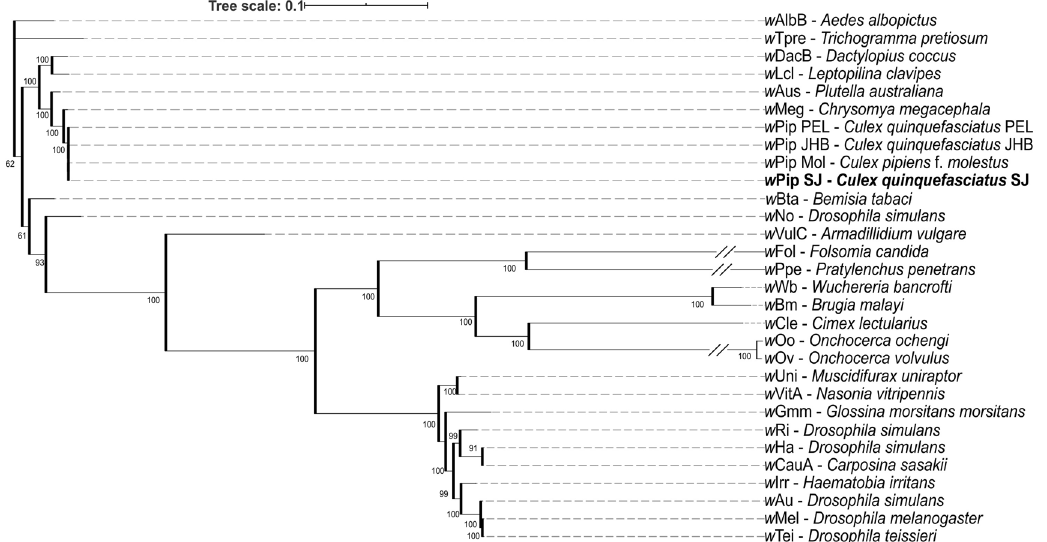
Figure 3. Maximum-likelihood phylogenetic tree reconstruction performed with GET_PHYLOMARKERS and IQ-TREE (500 ultrafast boostrap replicates) according to the Wolbachia core genome from 30 available genomes. Numbers in the branches indicate ultrafast bootstrap value, and letters on the right indicate the Wolbachia supergroup. The symbol // indicates a trimmed branch.